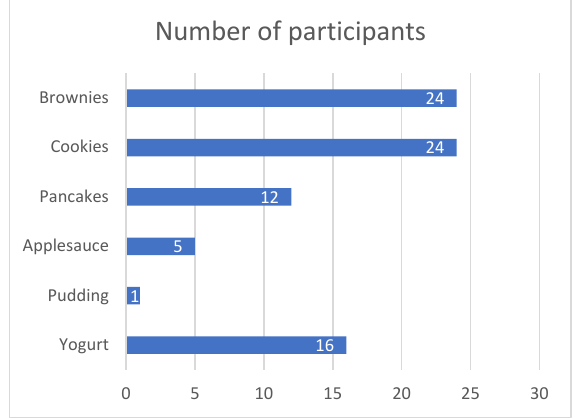
Figure 5. Bar chart of overall ranking of products.